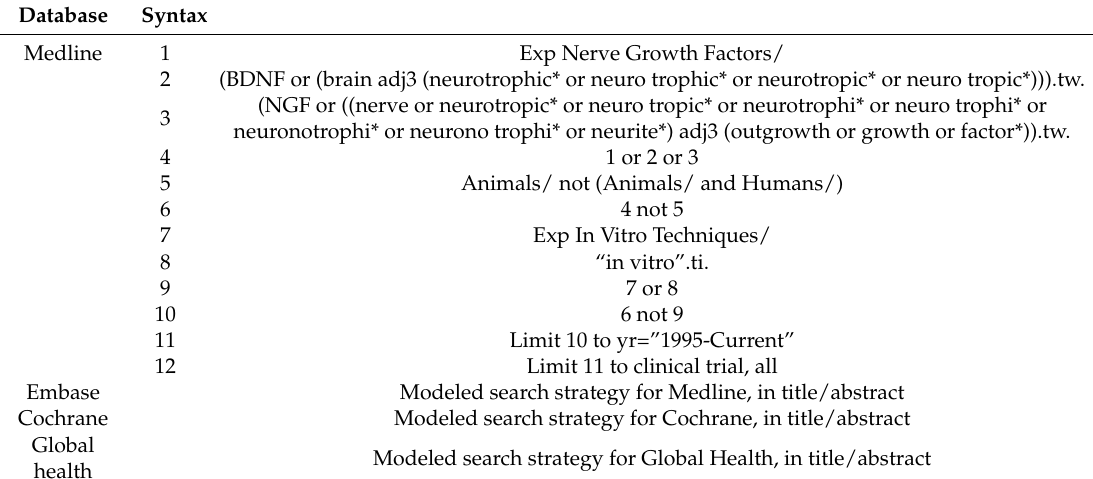
Table A1. Search